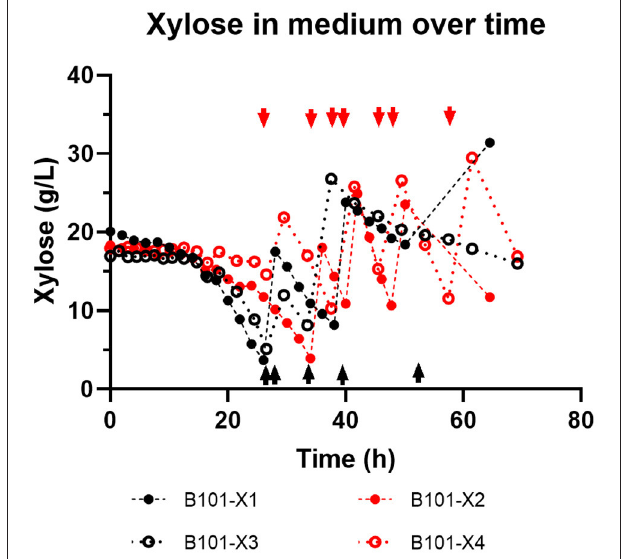
FIGURE 3 | Xylose concentration (g/L) in medium over time obtained for each fed-batch cultivation. B101-X1 and B101-X3 refer to experiments under nitrogen limitation (black dots/lines), while B101-X2 and B101-X4 refer to experiments under phosphorus limitation (red dots/lines). Black dashed lines mark the start of the accumulation phase under nitrogen limitation, while red dashed lines mark the start of the accumulation phase under phosphorus limitation. Arrows indicate feeding instants.